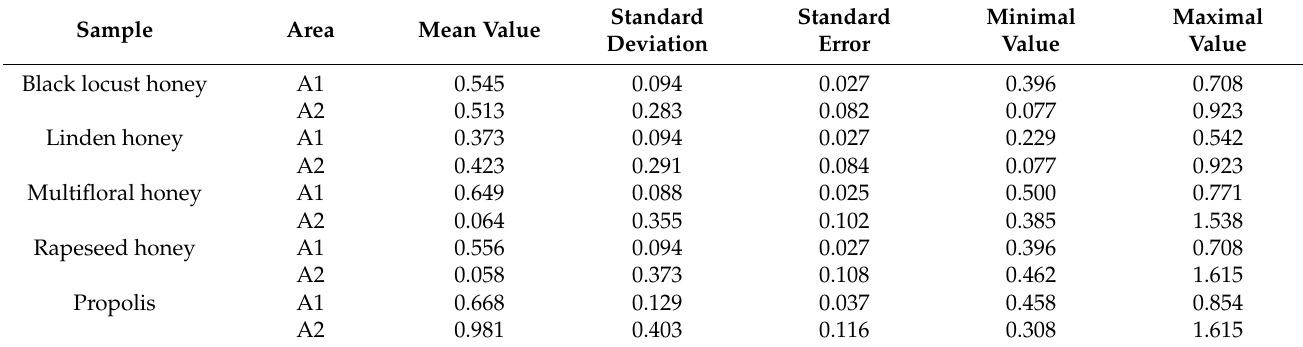
Table 13. Bioconcentration factor for p , p (cid:48) -DDT.